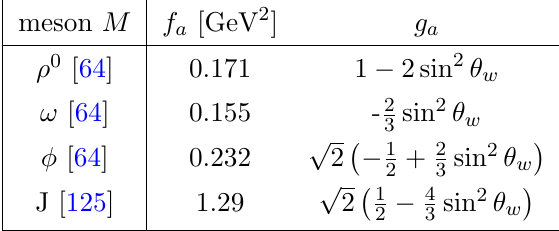
Table 10 . Decay constants and g a of neutral vector